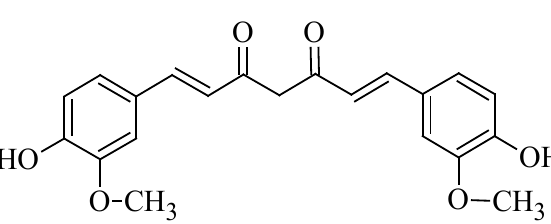
Figure 6. Chemical structure of